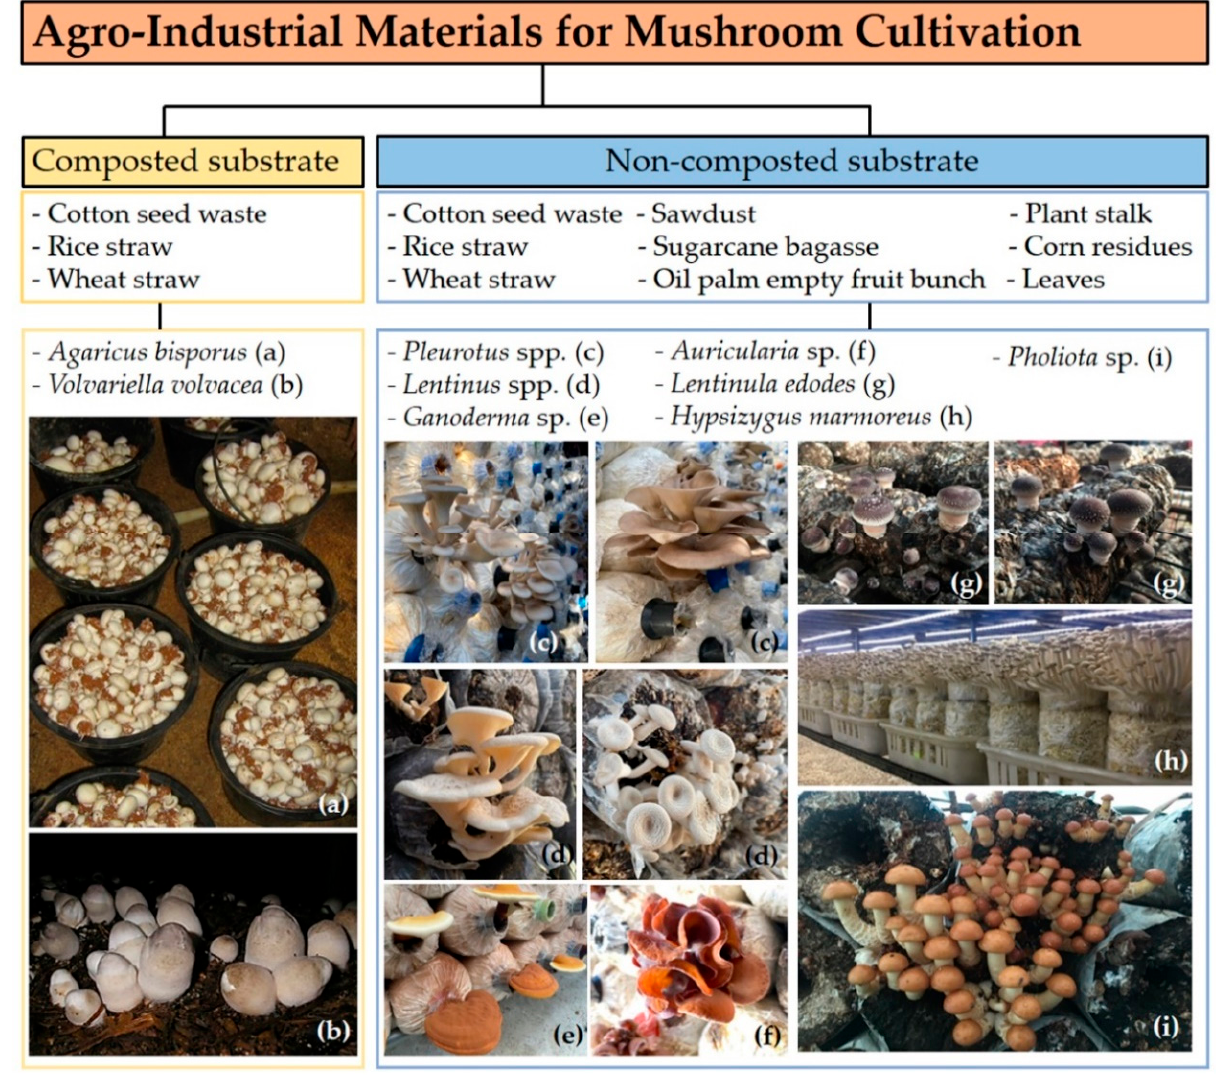
Figure 1. An illustration of the substrates used for mushroom production. Photo credit: Suwannarach, N.